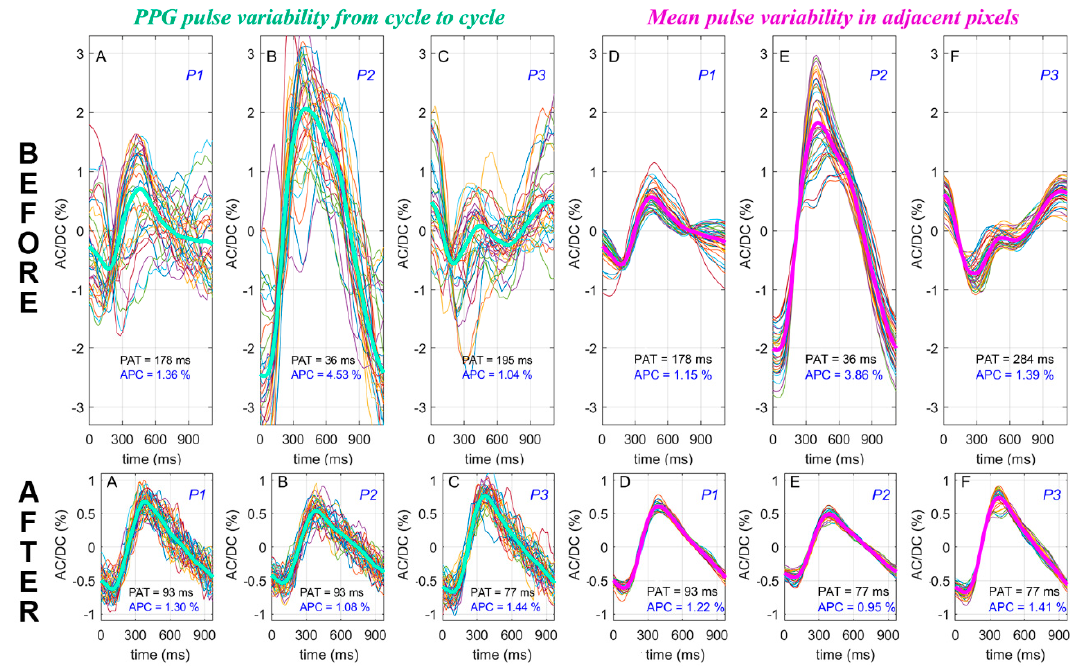
Figure 4. Variations of PPG-pulse shape in time and space in the case of carotid artery revascularization: The thin color lines in ( A − C ) show PPG pulses of 35 consecutive cardiac cycles calculated in the central pixel of ROIs marked by P1, P2, and P3, respectively. The positions of these ROIs in the cortex are shown in Figure 3. The thick green lines in these graphs are PPG pulses averaged over the cardiac cycles. The thin color lines in graphs ( D − F ) show the mean PPG pulses calculated in each of 49 neighboring pixels within respective ROIs marked by P1, P2, or P3. The thick pink lines in these graphs are the waveforms averaged over all pixels within the ROI. The upper and lower rows show the graphs before and after surgery, respectively.